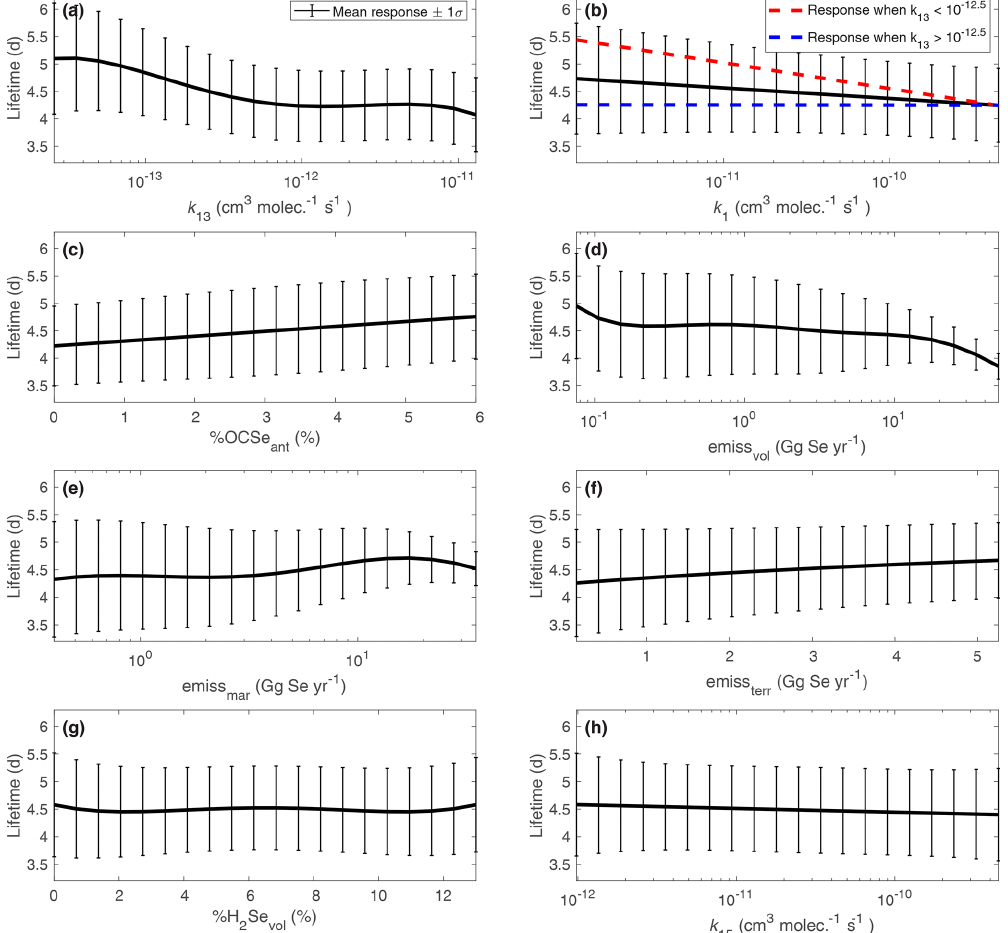
Figure 6. Relationships between the atmospheric Se lifetime and the most important input parameters from Fig. 5. Using resampling tech- niques (Sect. 3.5), we calculate the mean and standard deviation Se lifetime over the range of input parameters. Interaction effects are illustrated in the k 1 plot (b) , by grouping the samples into cases where k 13 is high and low.